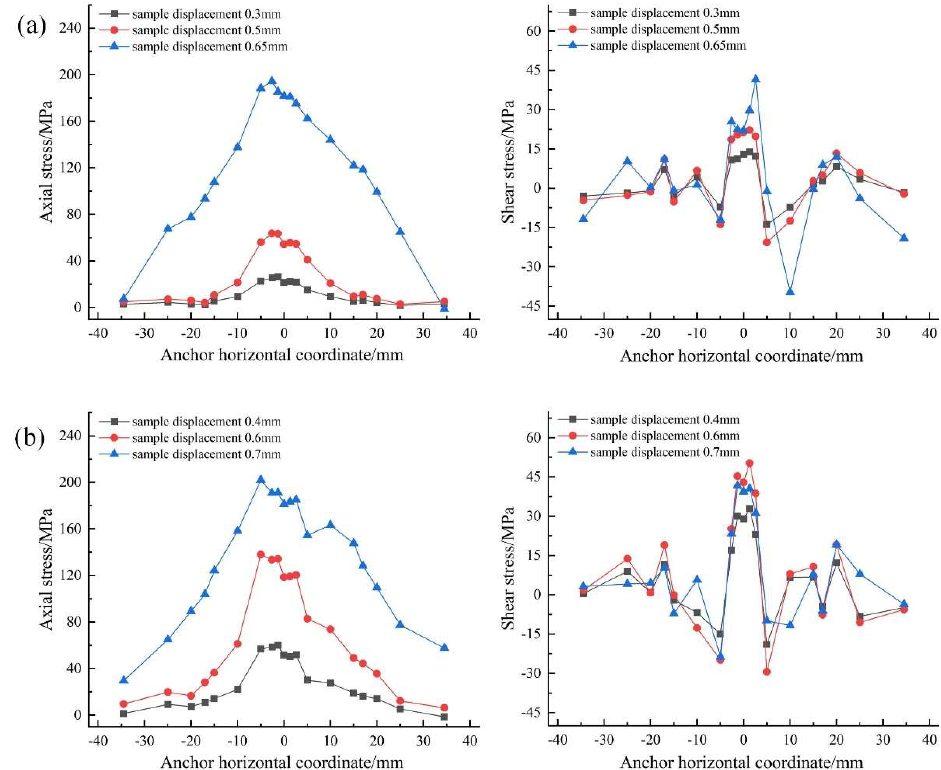
Figure 22. Axial and shear stress distribution for anchor: ( a ) F-75 sample; ( b ) R-75